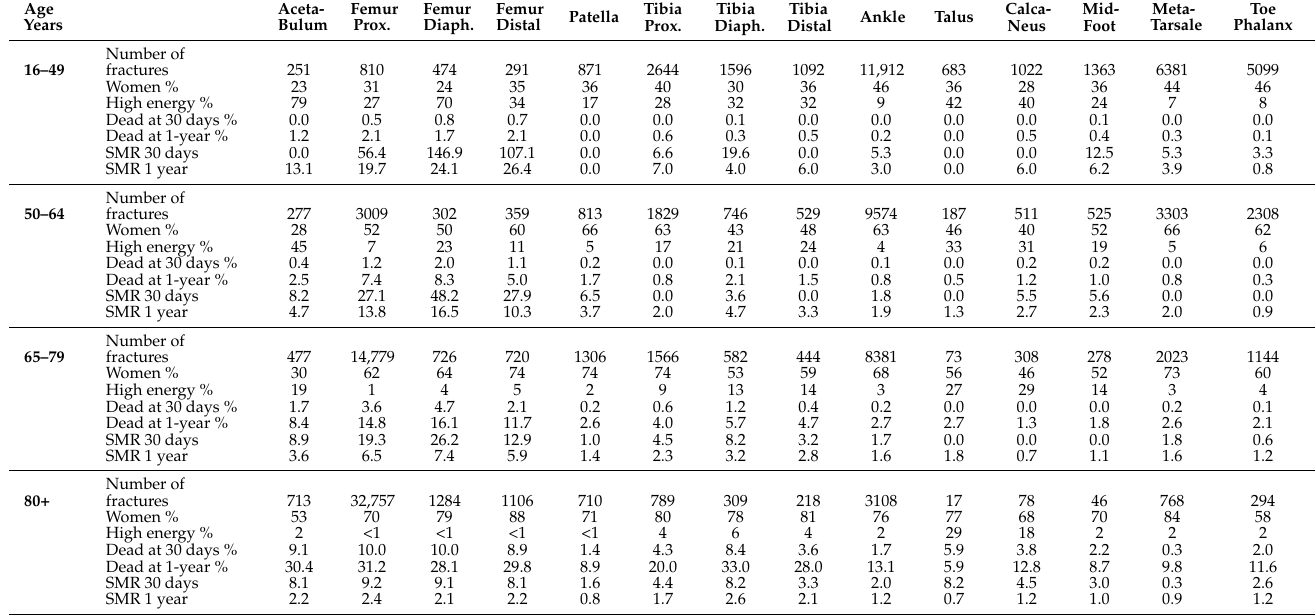
Table 2. Number of fractures, proportion of women (% total) and high-energy trauma (% total), mortality rate per time point after fracture, and standardized mortality rate (SMR) per time point after fracture for lower extremity injuries by age group.